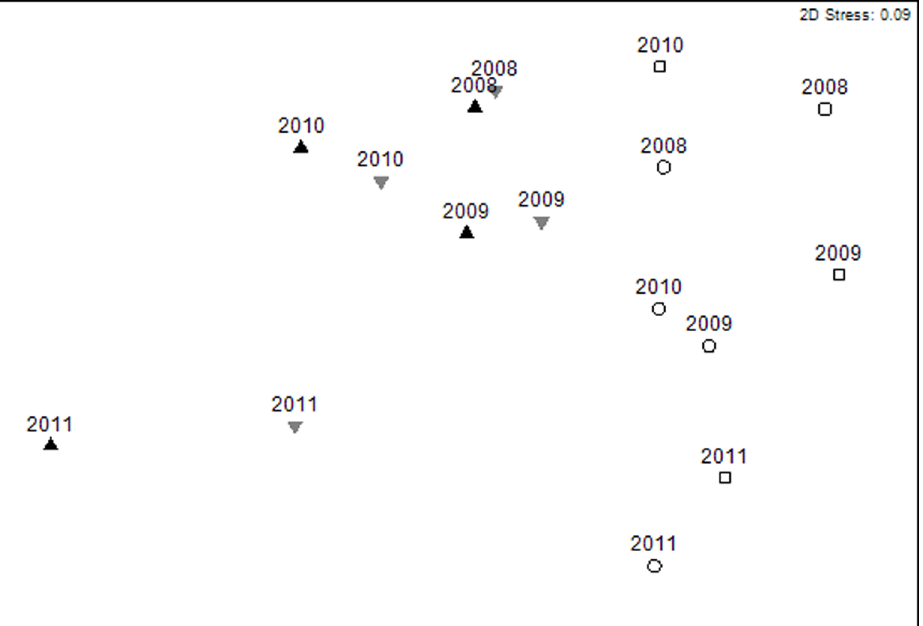
Figure 3. nMDS plot illustrating similarities in assemblage composition between Treatments (averaged for site within treatment), (closed control = filled black triangles, new closure = filled grey triangles, near open control = open circle, far open control = open square), over time (2008, 2009, 2010 and 2011). Data were dispersion weighted and square root transformed. Trajectories over time are indicated with lines from 2008 to 2011 for each